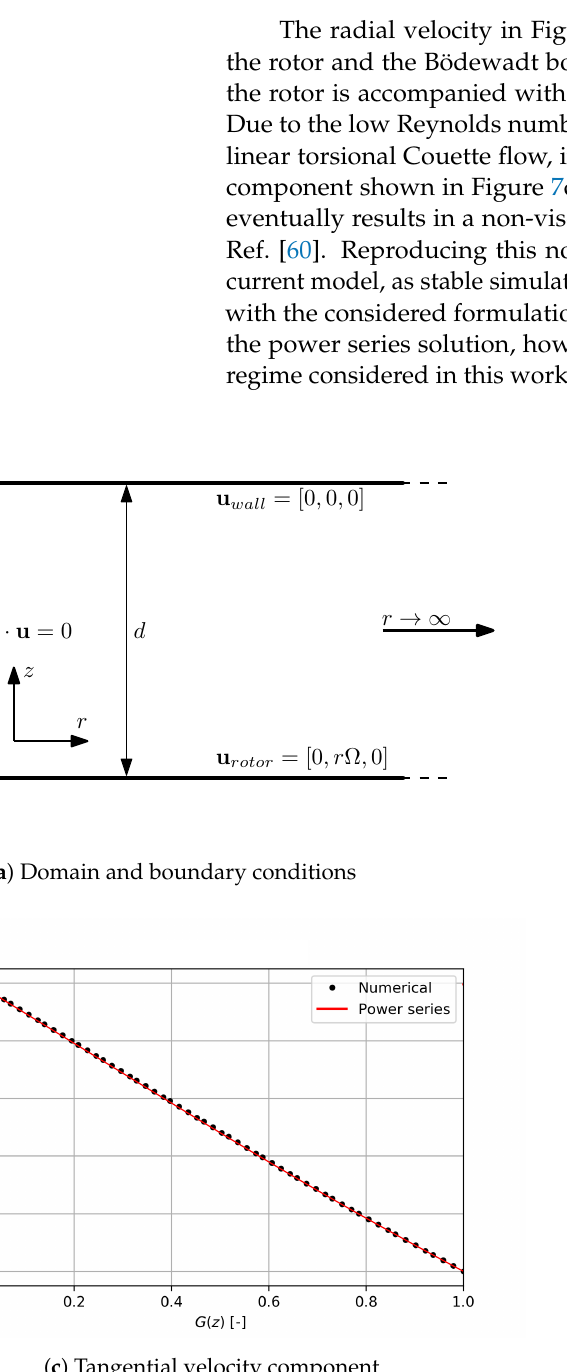
Figure 7. Infinite rotor-stator problem benchmark and results at Re d = 5, compared to reference power series data